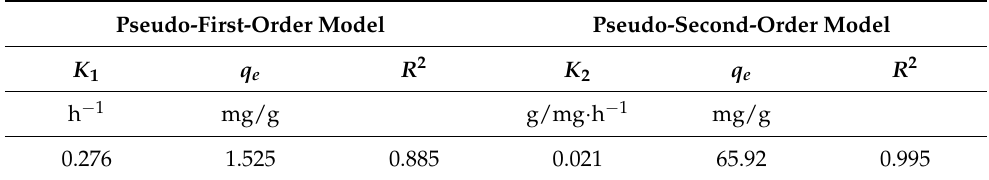
Figure 10. Kinetic fitting diagram of Cu 2+ (100 mg/L, pH = 5) adsorption on 5 wt% CTS-MMT composite fiber membrane: ( a ) quasi-first-order kinetic model, ( b ) quasi-second-order kinetic model. Table 1. Kinetic fitting parameters of Cu 2+ adsorption on 5 wt% CTS-MMT composite fiber membrane.